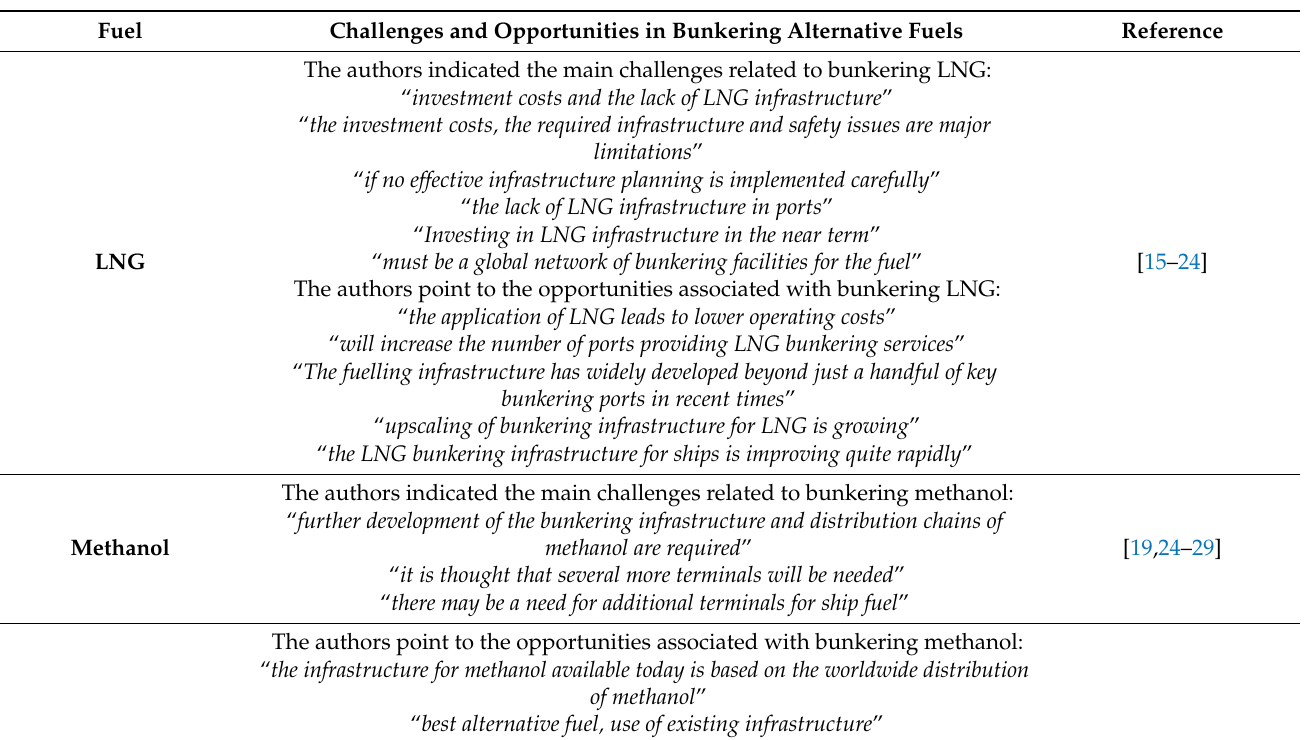
Table 1. An overview of key issues regarding bunkering alternative